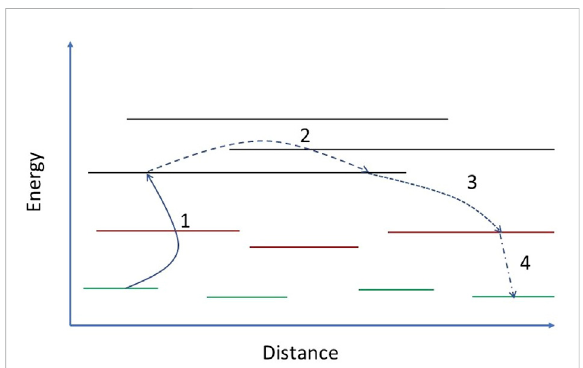
FIGURE 11 A schematic diagram representing intrachain transient exciton delocalization. The green, red and black horizontal lines represent the spatial extent of exciton-polarons, local exciton ground states (LEGSs) and quasiextended states (QEESs), respectively. (1) The exciton is thermally excited from its bound polaron state to a QEES. (2) Motion in the delocalized QEES is quasiballistic over long distances. (3) The exciton stochastically relaxes onto a LEGS (see Section 4.2). (4) Torsional relaxation causes an exciton-polaron (see Section